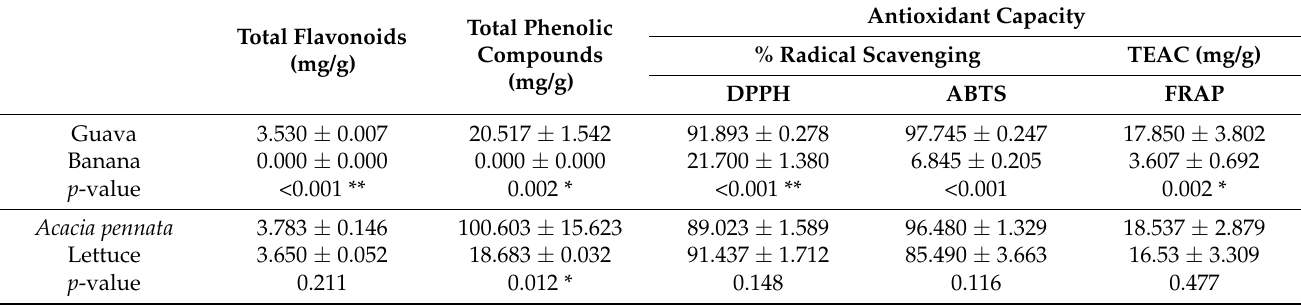
Figure 2. The flavonoid content, phenolic compounds, and antioxidant capacity levels of certain fruits and vegetables. Two fruits and two vegetables those are guava fruit, banana, Acacia pennata , and lettuce vegetables were analyzed for total flavonoids ( a ), total phenolic compounds ( b ), and total antioxidant capacity using 2,2-diphenyl-1-picrylhydrazyl (DPPH) assay, 2,2’-azino-bis (3- ethylbenzothiazoline-6-sulfonic acid) (ABTS) assay ( c ), and ferric-reducing antioxidant power (FRAP) assay ( d ). * and ** were significant at p < 0.05 and p < 0.001 analyzed by independent sample t -test, respectively. Table 5. Mean and standard deviation of flavonoid content, phenolic compounds, and antioxidant capacity levels of certain fruits and